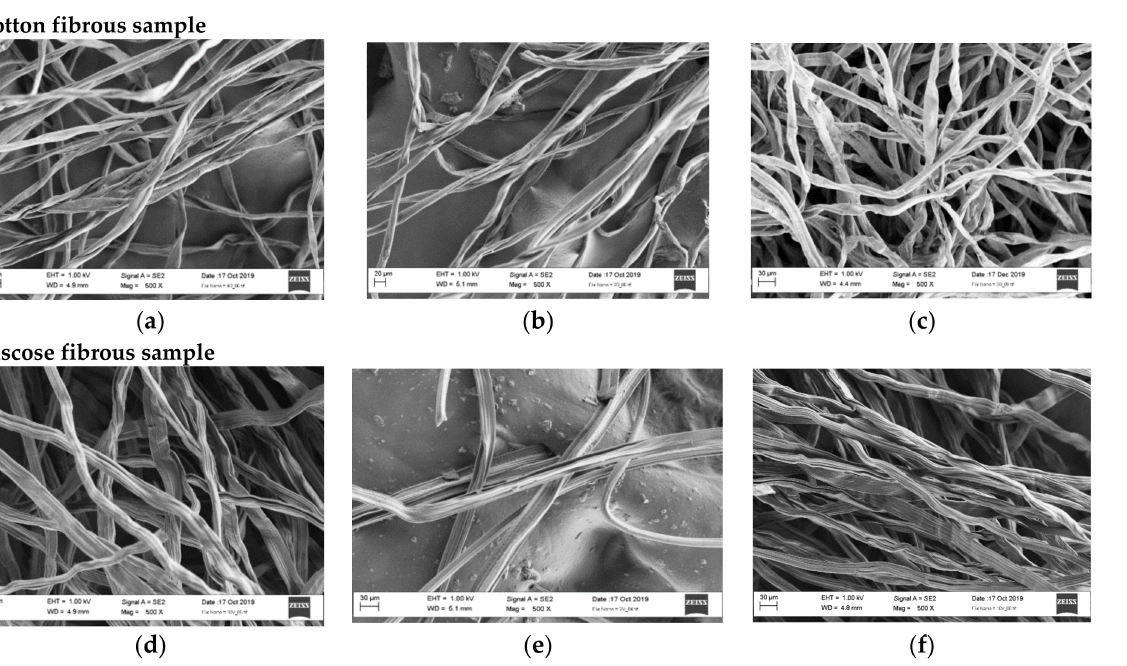
Figure 5. The SEM images of ( a ) untreated cotton fibrous tampon, ( b ) cotton fibrous sample functionalized by CBD liposome liquid formulation, ( c ) cotton fibrous sample functionalized by CBD oil, ( d ) untreated viscose fibrous sample, ( e ) viscose fibrous sample functionalized by CBD liposome liquid formulation and ( f ) viscose fibrous sample functionalized by CBD oil at magnification factor range of 500 ×